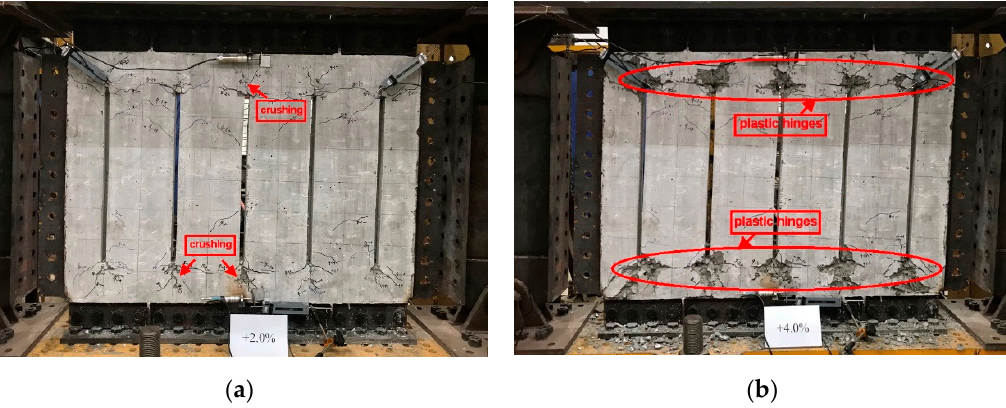
Figure 6. Images of RCIP-1 in different states: ( a ) at a drift ratio of 2%; ( b ) front view after the test. Specimen RCIP-2 had CVSs in its RC panel. Compared to RCIP-1, RCIP-2 showed a typical shear-dominated deformation pattern. The first crack appeared in the CVSs, and the inclined angle was approximately 90° to the horizontal direction. More vertical slits were then formed in the CVSs. The extended inclined cracks in the slit walls oriented at approximately ±45° to the horizontal direction were monitored until the drift ratio reached 0.75%. At a drift ratio of 1%, the concrete in the CVSs started rupturing and spalling. When the drift ratio reached 1.5%, the long-inclined cracks extended gradually, and some CVSs penetrated the specimen (Figure 7a). RCIP-2 reached the maximum lateral load-bearing capacities of 187.5 and − 182.7 kN in the positive and negative loading directions, respectively, which were higher than those of RCIP-1. Plastic hinges were formed at both slit wall ends when the drift ratio reached 2%, and the concrete at the slit wall root started to spall. The vertical rebars buckled until the drift ratio reached 4% because of concrete cover spalling (Figure 7b).